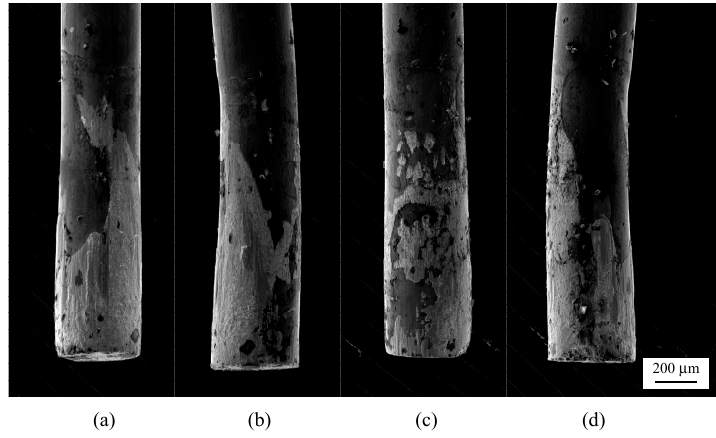
Figure 5. Load-displacement diagrams: ( a ) Specimens SC-0.5-1 to 6; ( b ) Specimens SC-0.5-7 to 11.